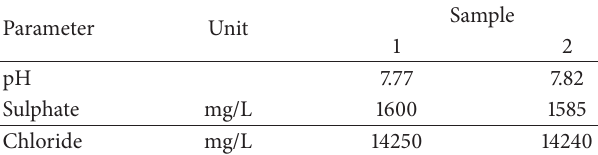
Table 6: Main aggressive element in sea